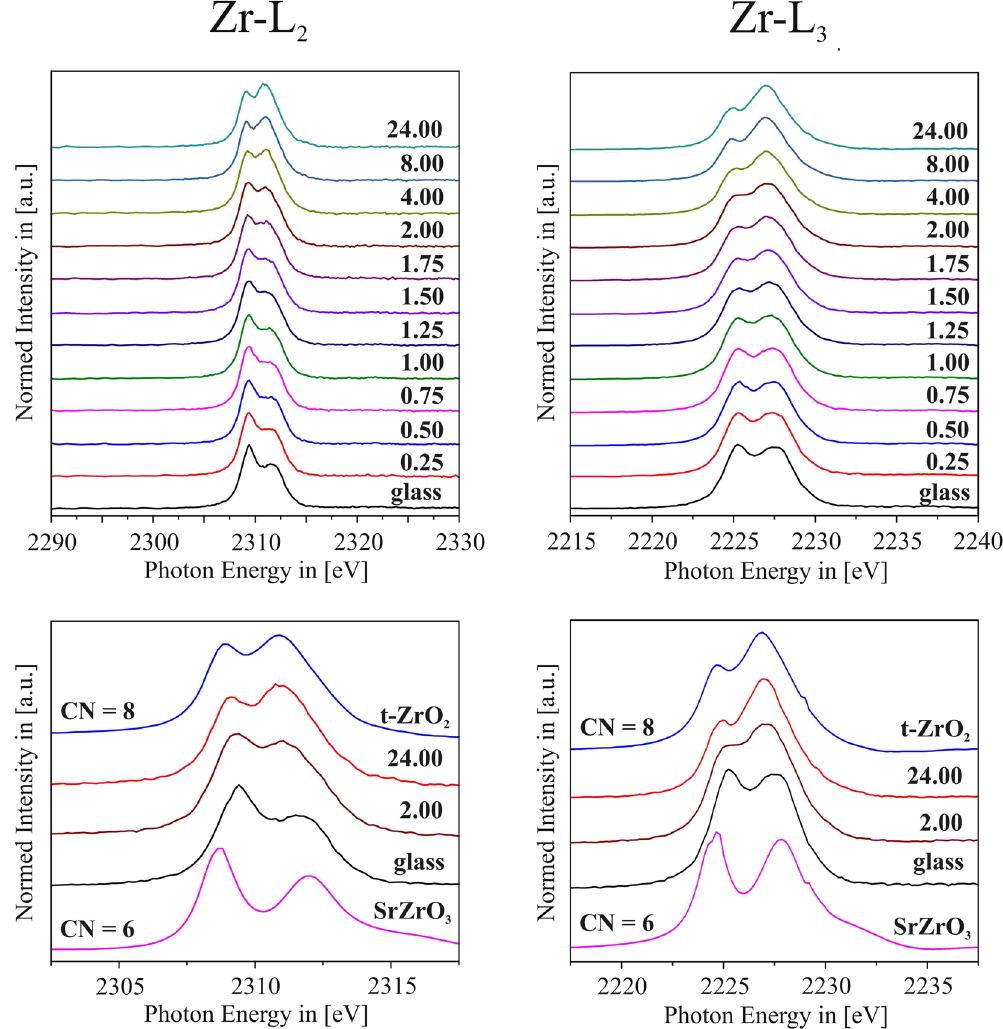
Figure 8. Top left and right: Summarized results of the Zr L 2 and Zr L 3 XANE spectra of samples heat treated at 725 °C for t = 0.25–24 h, showing the gradual change of the respective edges peak shape. Bottom left and right: Zr L 2 and Zr L 3 XANE spectra of reference materials that incorporate Zr 4 + ions in sixfold (SrZrO 3 ) and eightfold (t-ZrO 2 ) coordination, and of the green glass sample as well of the samples thermally treated at 725 °C for t = 2 h and t = 24